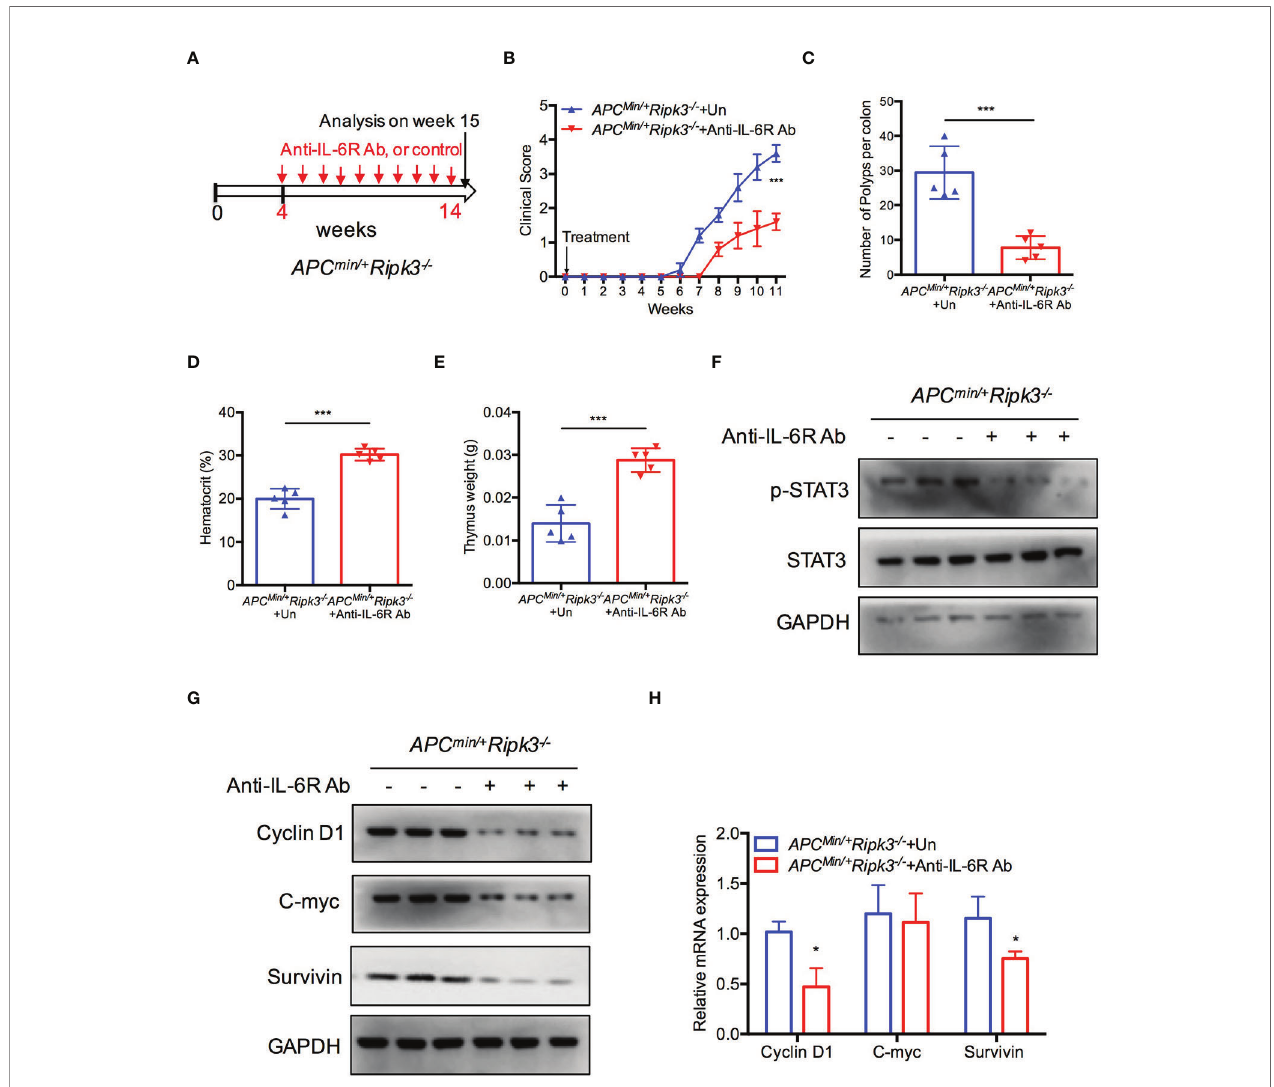
FIGURE 4 | Inhibition of IL-6 blocks tumor burden in Apc min/+ Ripk3 -/- mice. (A) Scheme for anti-IL6R antibody treatment in Apc min/+ Ripk3 -/- mice. (B) Four-week-old Apc min/+ Ripk3 -/- mice were injected with anti-IL6R antibody with at a dosage of 4 mg/kg weekly for 10 weeks. The clinical scores were monitored. (C) Numbers of intestinal tumors in Un- or anti-IL6R-treated Apc min/+ Ripk3 -/- mice. (D, E) Hematocrit (D) and thymus weight (E) of Apc min/+ Ripk3 -/- mice after anti-IL6R therapy for 10 weeks. (F) Intestinal tumors were collected from PBS and anti-IL6R-treated Apc min/+ Ripk3 -/- mice. The levels of p-STAT3 were determined by western blotting. (G, H) The expression of STAT3 target genes expression in PBS and anti-IL6R-treated Apc min/+ Ripk3 -/- intestinal tumors. * p < 0.05, *** p < 0.001 versus Un-treated Apc min/+ Ripk3 -/-